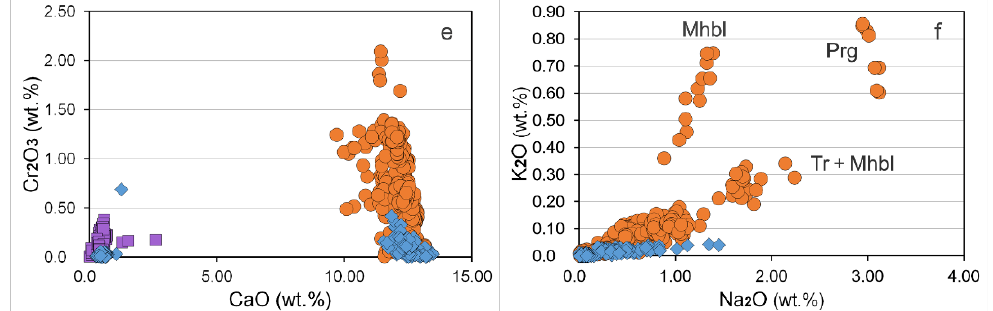
Figure 12. ( a – f ). Plot of contents of SiO 2 vs. Al 2 O 3 ( a ), MgO vs. FeO ( b ), TiO 2 vs. MgO ( c ), TiO 2 vs. MnO ( d ), CaO vs. Cr 2 O 3 ( e ), and Na 2 O vs. K 2 O ( f ), all expressed in weight %, in WDS compositions of amphiboles from the Lyavaraka complex (this study, orange circles), compared with those of amphiboles from the Chapesvara complex (blue diamond symbol; after [12]). WDS compositions of low-calcium Mg–Fe amphiboles of the Lyavaraka complex are shown by purple squares. The symbols Tr, Mhbl and Prg stand for tremolite, magnesio-hornblende and pargasite, respectively.